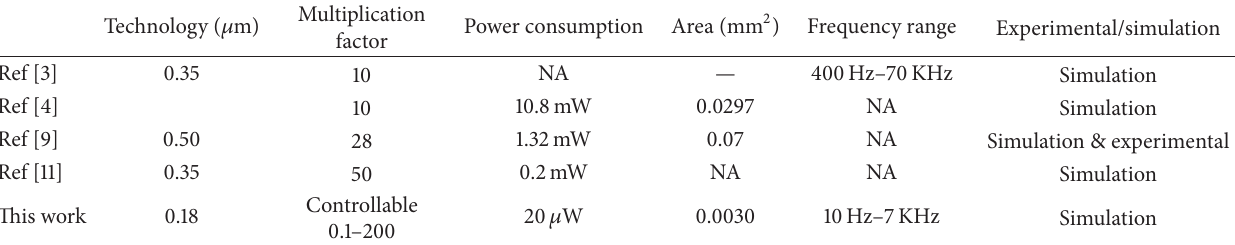
Table 1: Performance